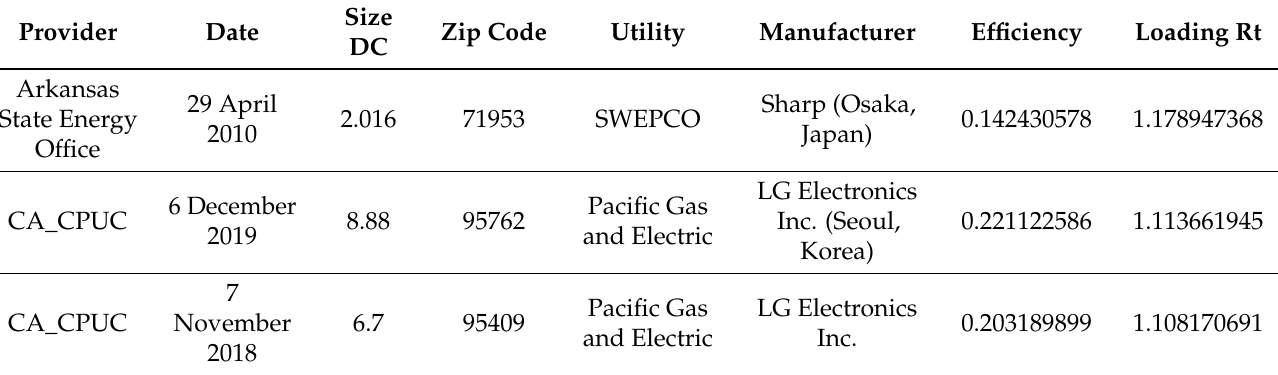
Table 2. National Renewable Energy Laboratory, Department of Energy’s Open Energy Data Initiative (OEDI) [49]. The dataset consists of 1 million solar cell systems along with 78 columns of information on each system.